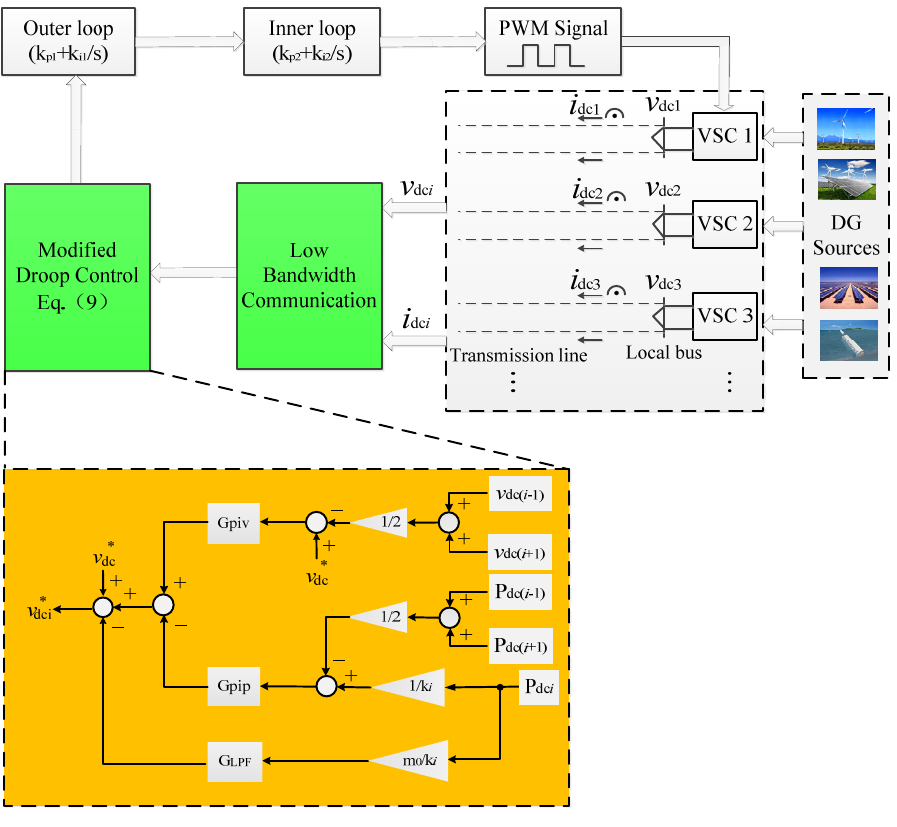
Figure 4. Detailed diagram of the proposed droop control system.